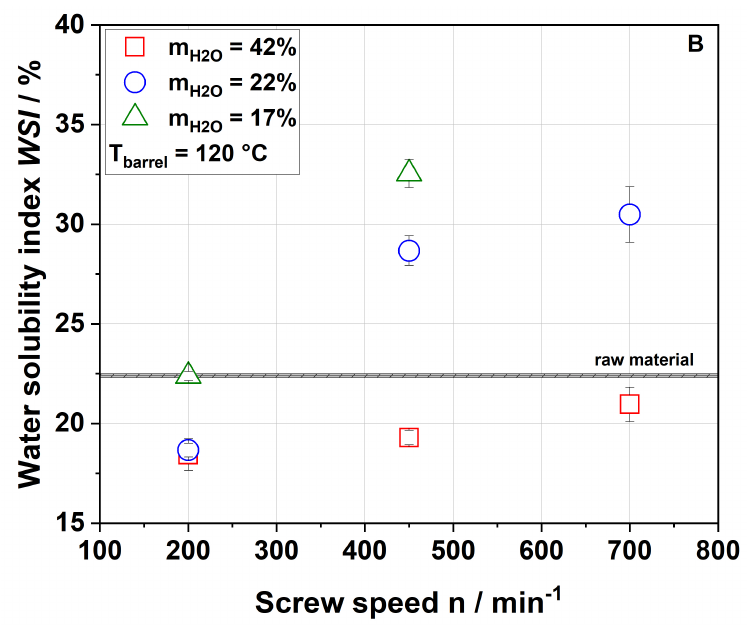
Figure 3. E ff ect of screw speed and water content on the water solubility index (WSI) at ( A ) 100 ◦ C barrel temperature and ( B ) 120 ◦ C barrel temperature. Values of the raw material are marked as a black line, whereas values of extruded samples are given as